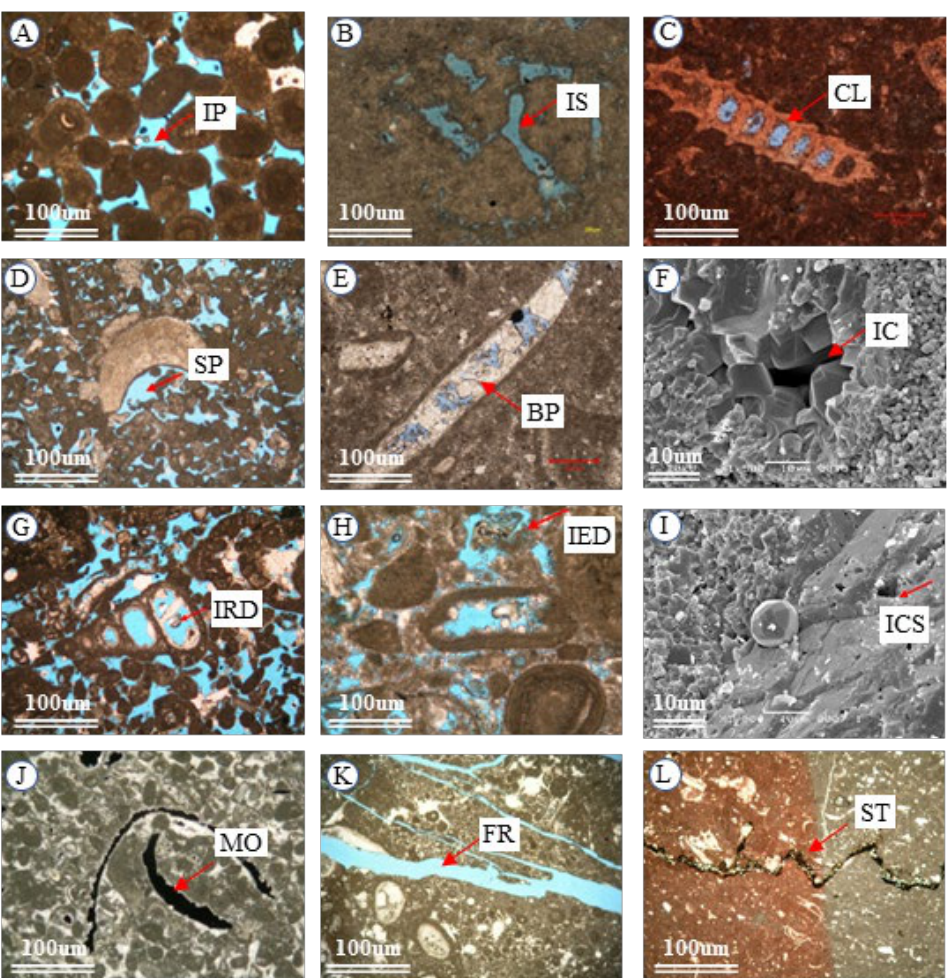
Figure 7. Photomicrographs and SEM images of various pore types of the Callovian-Oxfordian stage ( A – L ). They include interparticle (IP), intraskeletal (IS), coelomopore (CL), shadow pore (SP), bioboring pore (BP), intercrystalline (IC), intragranular dissolved pore (IRD), intergranular dissolved pore (IED), intracrystal solution pore (ICS), modic (MO), fracture (FR), and stylolite (ST) pore type. (1) Primary pore